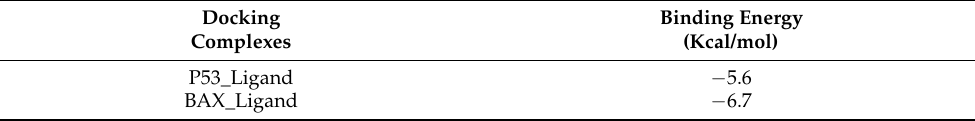
Table 7. The binding energy of stressed compound